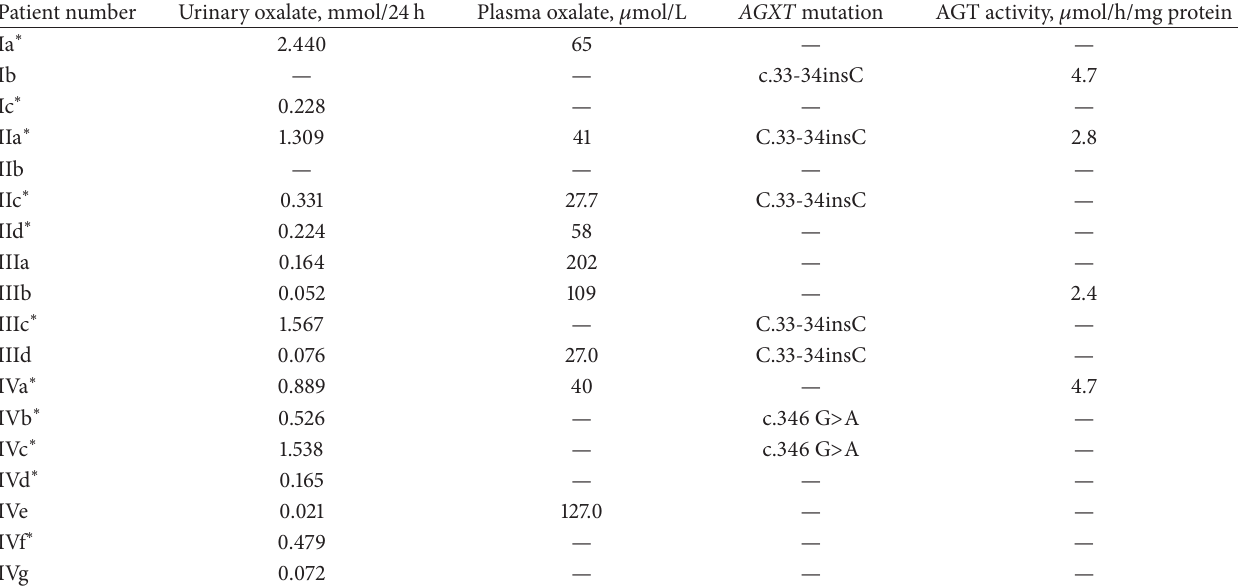
Table 3: 24-hour urinary oxalate, plasma oxalate, AGXT mutations and AGT